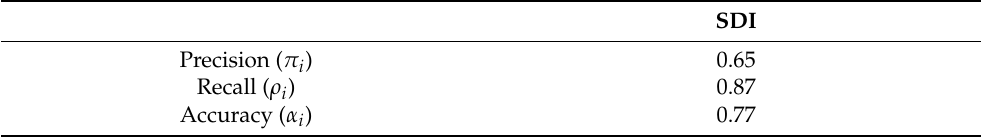
Table 3. Actual performance characteristics of the SDI